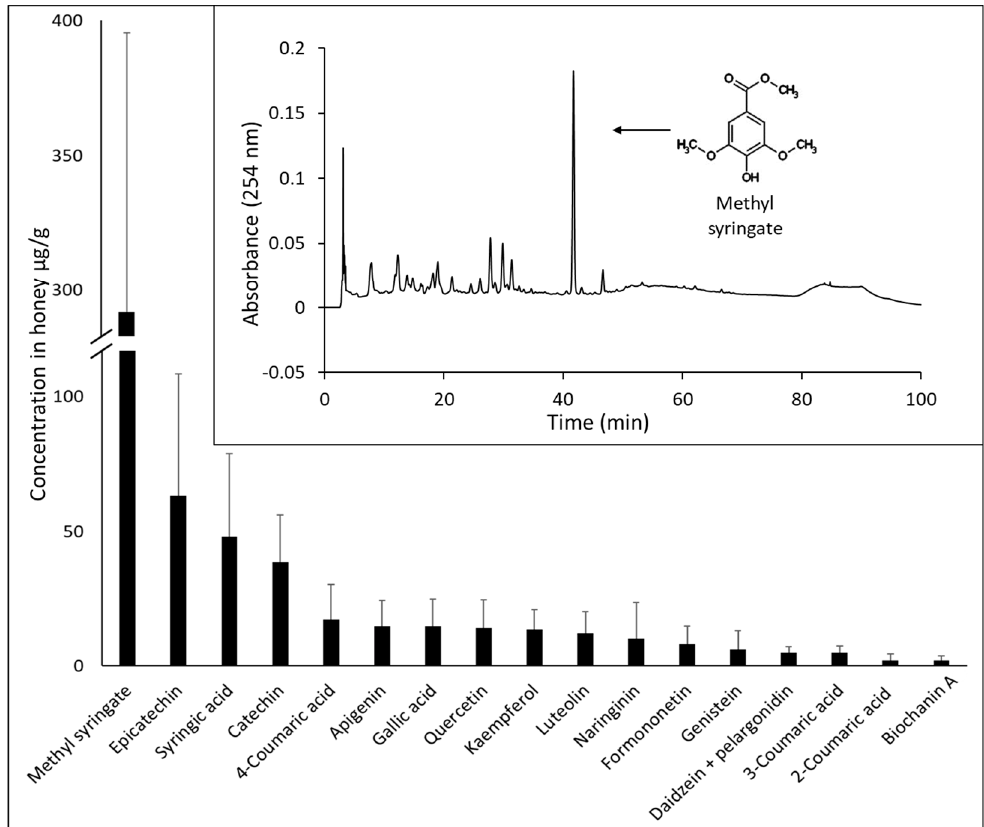
Figure 2. Polyphenol composition of Zantaz honey. Values are averages ± SD of 10 samples. Inset presents a typical RP-HPLC polyphenol profile and the structure of methyl syringate.